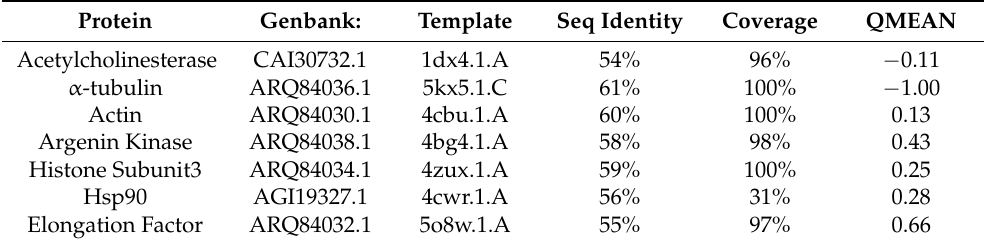
Figure 1. ( A ) acetylcholinesterase, ( B ) α -tubulin, ( C ) actin, ( D ) arginine kinase, ( E ) histone subunit III ( F ) Hsp90, ( G ) elongation factor 1-alpha, and ( H ) carbamoyl phosphate synthase of the Liriomyza trifolii modeled proteins through homology modeling using the Swissmodel server and visualized through the Discovery Studio 3.0 visualization tool [19]. The large red sphere represents the cavities surrounding the active sites and was visualized using the visualization module of Discovery Studio 3.0 visualization. Table 2. Protein Genbank sequences and modeling parameters for building with template ID, sequences identities, the coverage of the protein, and quality mean estimation for validation of the protein in